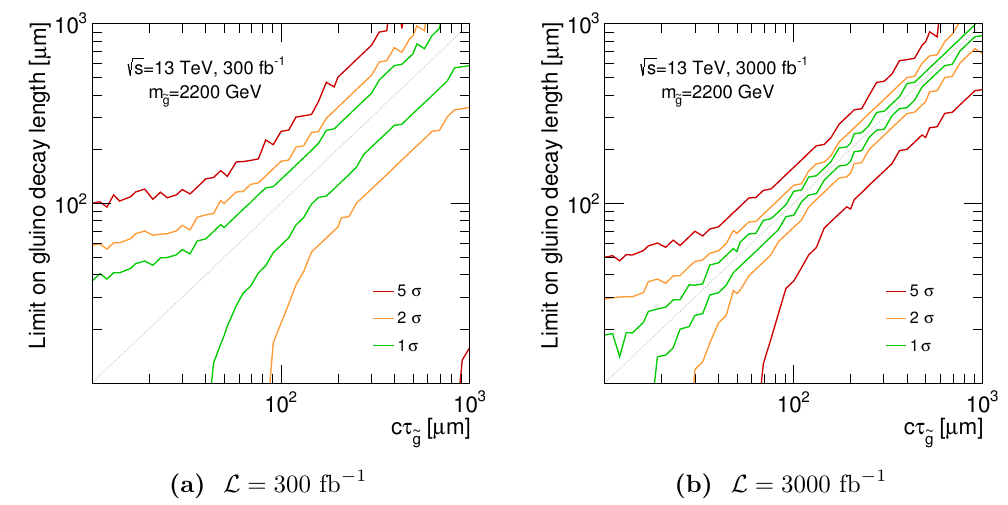
Figure 14. The expected upper and lower bounds on the decay length of gluino as a function of the underlying value of c(cid:28) ~ g . Here, we set m ~ g = 2 : 2 TeV, and impose preselection-H and a selection cut m e(cid:11) (incl : ) > 3500